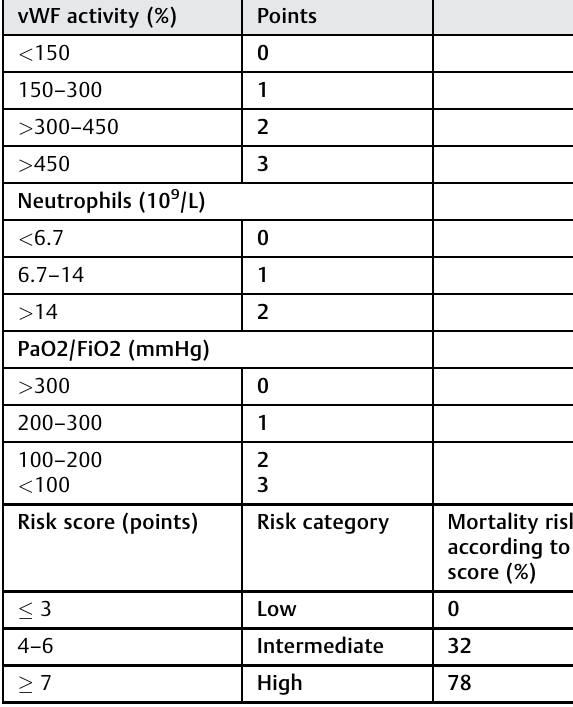
Abbreviations: ARDS, acute respiratory distress syndrome; vWF, von Willebrand